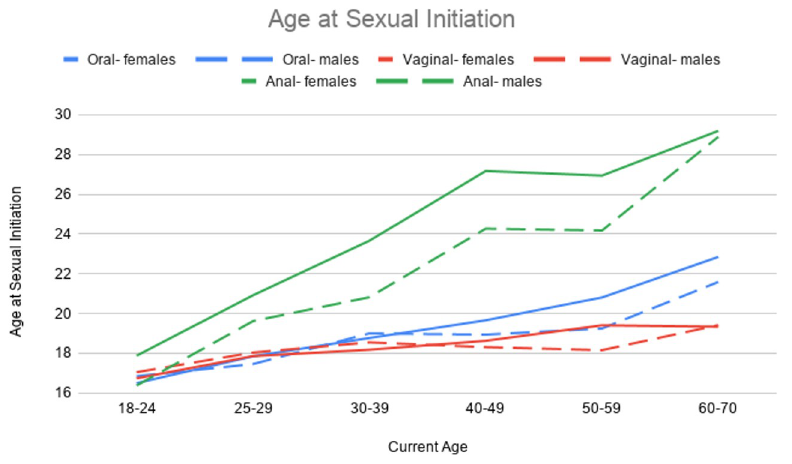
Fig 4. Age trends in age of initiation in oral, vaginal, and anal